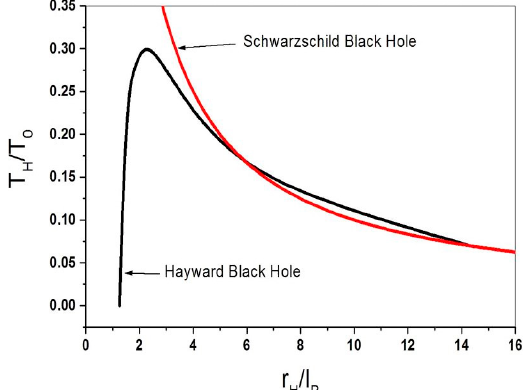
Figure 2 . Normalized horizon temperature for Hayward (black curve) and Schwarzschild (red curve) black holes as a function of the horizon radius in units of the Planck scale distance.